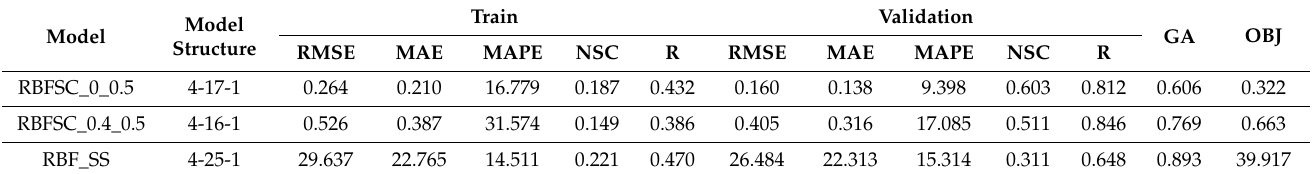
Table 5. Structures and error metrics of the best RBF neural